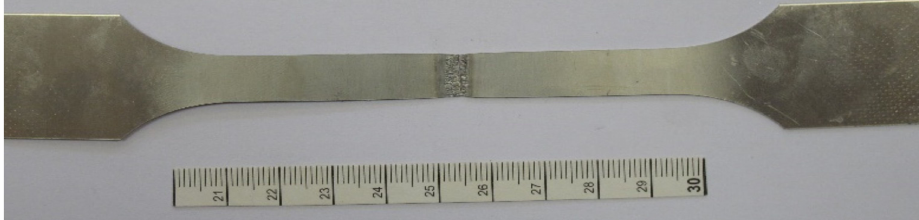
Figure 6. Weld metal specimen of sample 1.